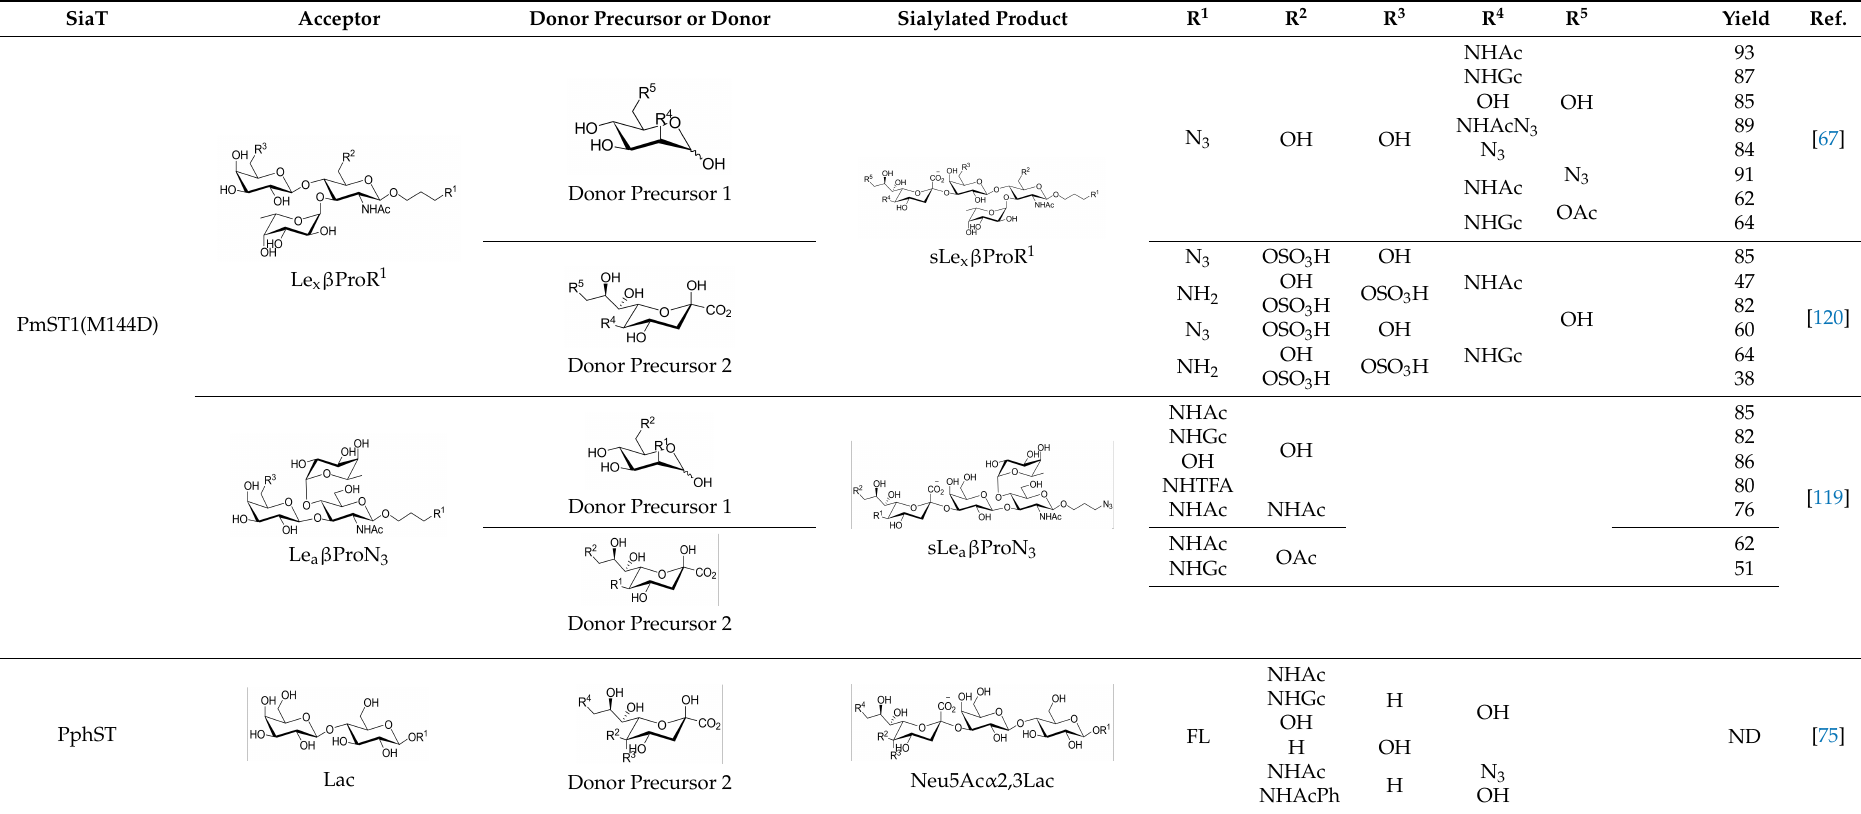
Table 2. Examples of in vitro chemoenzymatic sialylation achieved with bSiaTs or their mutants. Acceptor substrates, donor substrates, or their precursors used in OPME systems, sialylated products, derivatized moieties (R1-R5), yields, and references are also listed. The abbreviations are as follows: CTP, cytidine triphosphate; CSS, CMP-sialic acid synthetase;